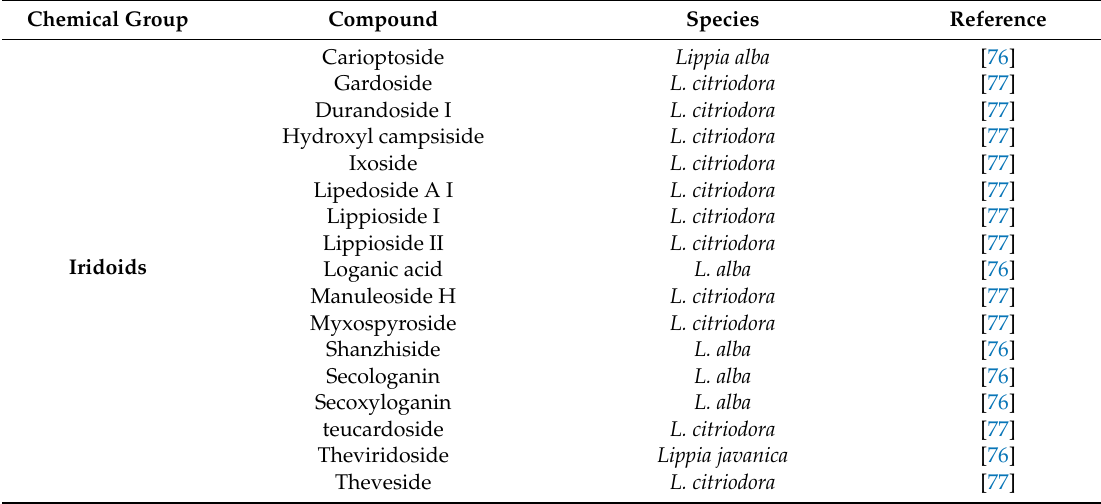
Table 3. Representative phytochemicals found in aerial parts of Lippia genus